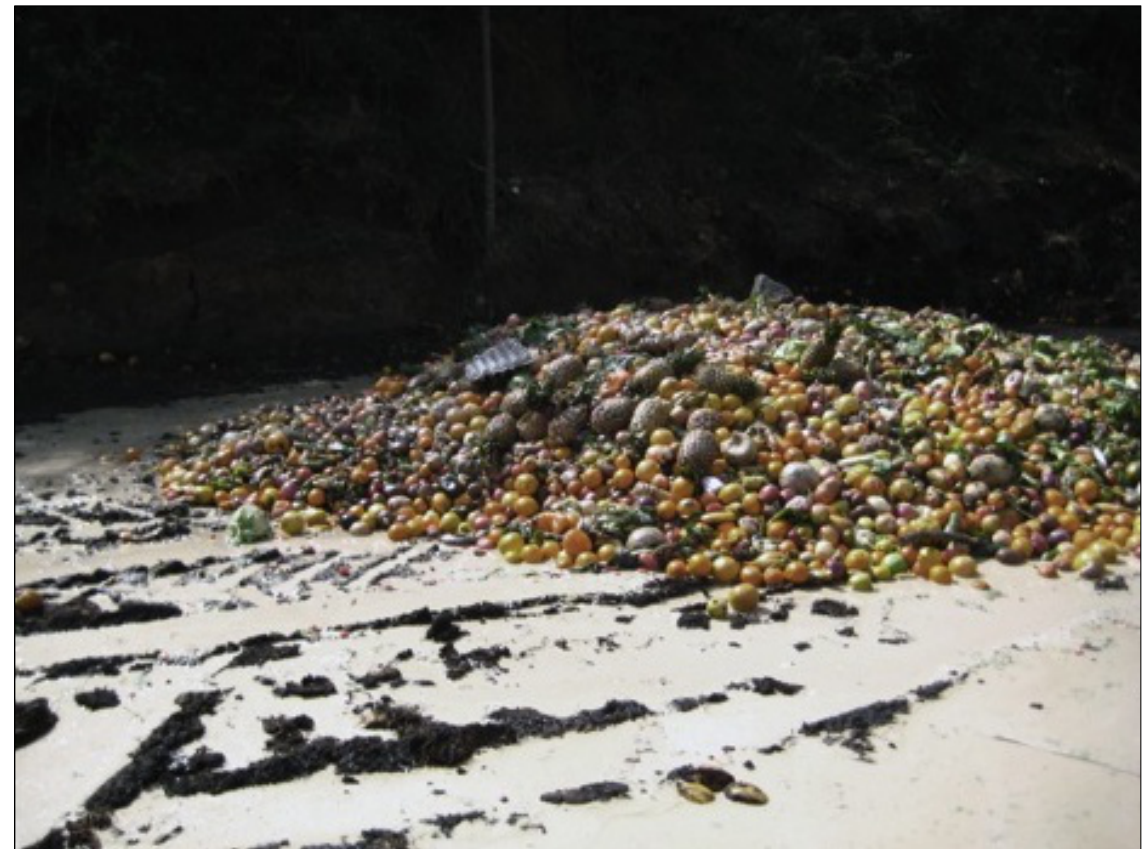
Figure 4. Walmart sends its food scraps to Brinson Poultry Farm by the